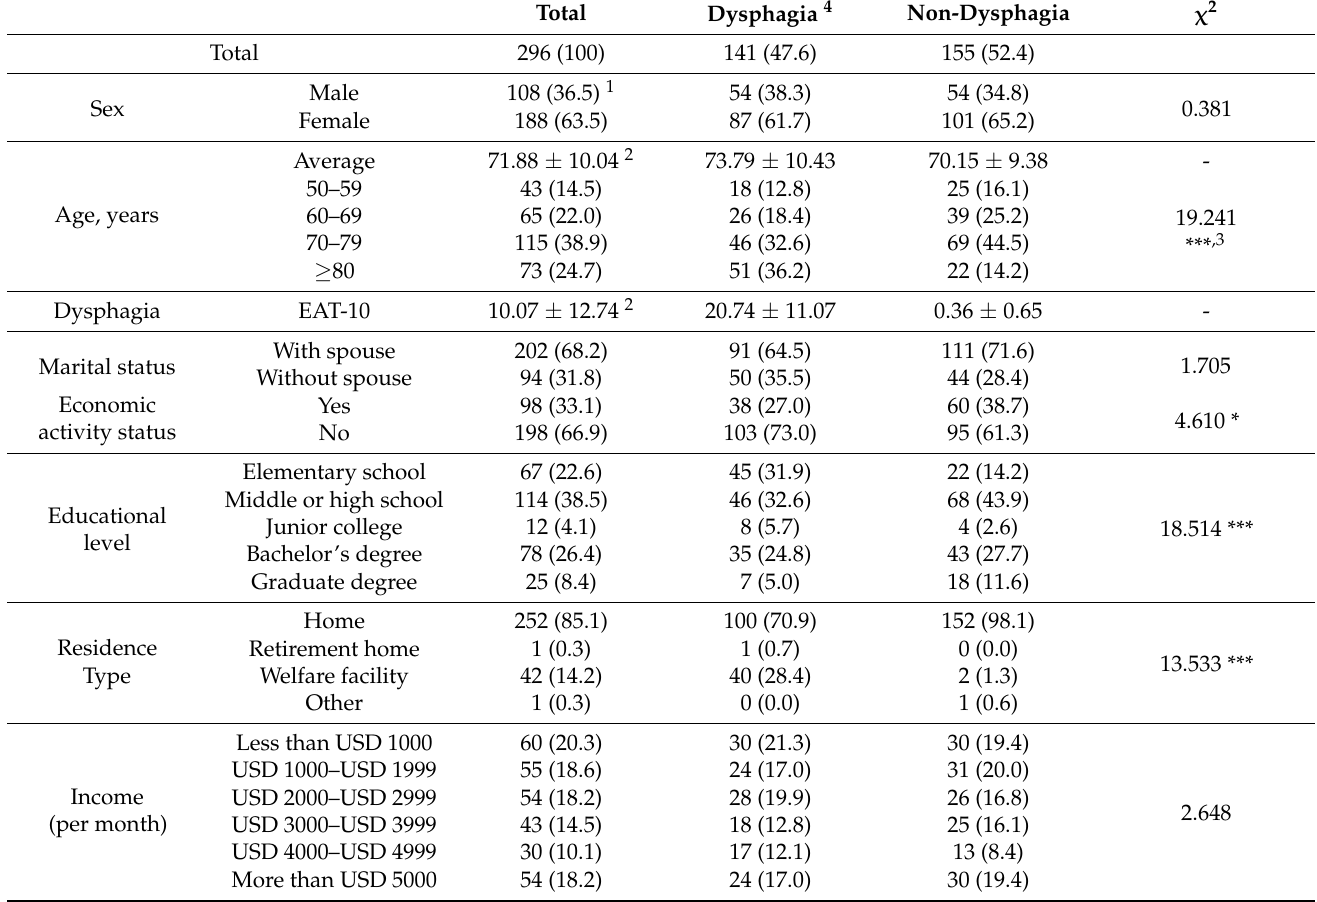
Figure 1. Study flow chart. Table 1. Subject Characteristics.